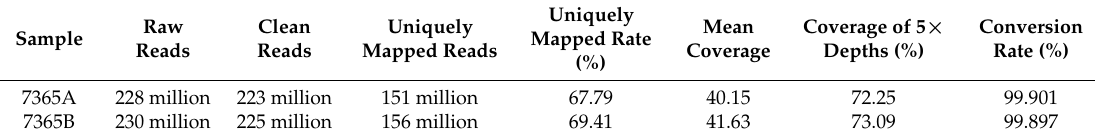
Table 1. Summary of genome-wide methylation sequencing data. Table 1 . Summary of genome‐wide methylation sequencing data.